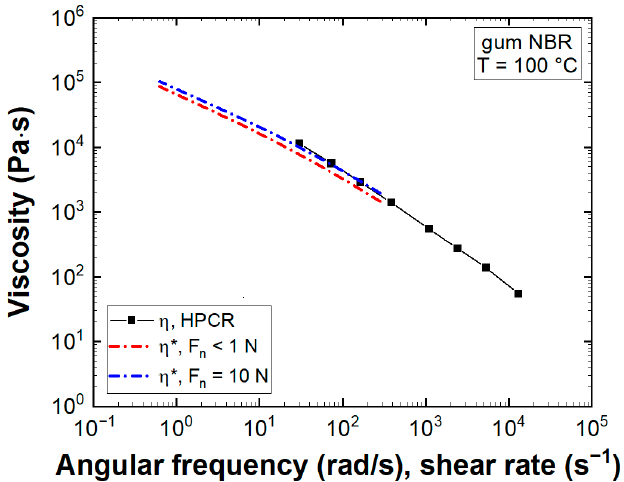
Figure A4. Complex viscosities η ∗ compared to steady-state shear viscosity η .